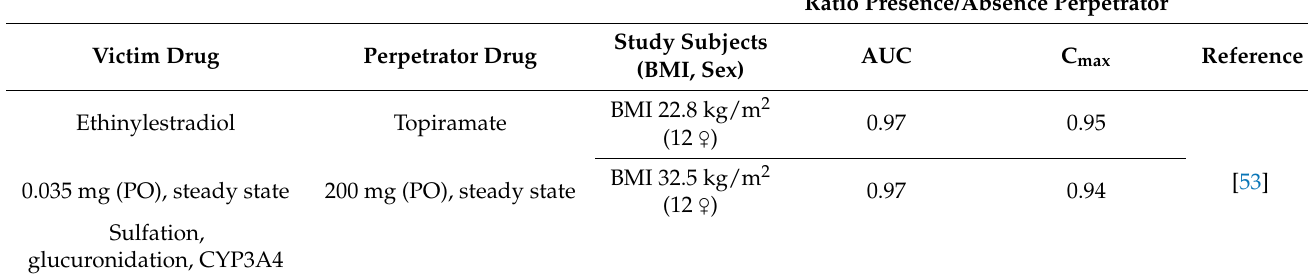
Table 6. Comparison of DDI magnitudes with inducers impacting drug metabolism in obese individ- uals relative to lean